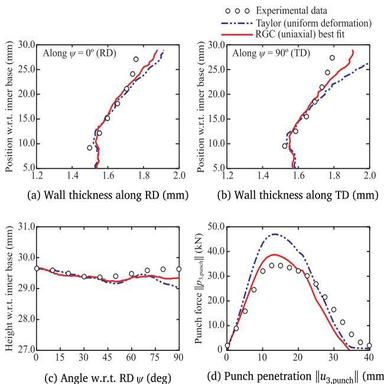
Results of the deep drawing simulations using the Relaxed Grain Cluster (RGC) and the TAYLOR scheme in comparison to experimental investigations. RD: Rolling Direction, TD: Transverse Direction. Figure adopted from with permission from IOP Publishing.